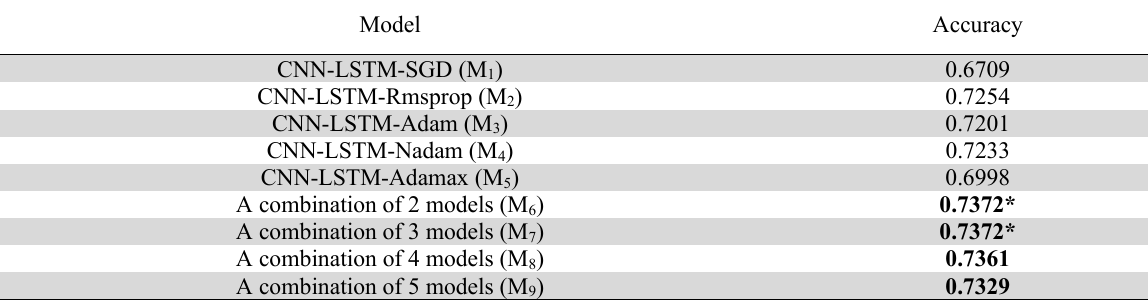
The performance of each model on the COVID-19 fake news